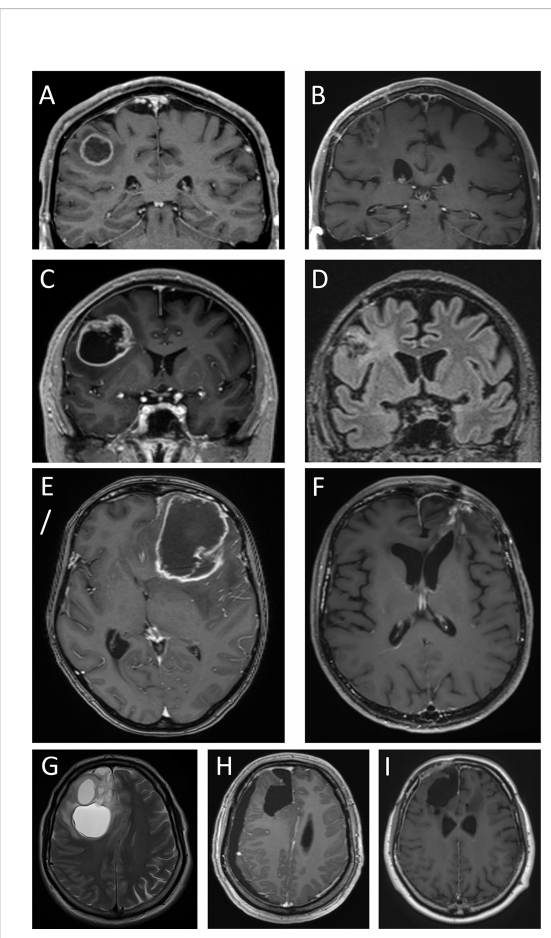
FIGURE 4 Four cystic glioblastomas before and after tumor surgery. T1 weighted MPRAGE MRIs after intravenous injection of gadolinium-based contrast medium (which gives the ring- formed bright signal in most images), except in D and G, which are T2-weighted and T2-weighted FLAIR, respectively. Images (A, C, E, G) show pre-surgical MRIs. Note the modest displacement of surrounding brain tissue (compare with contralateral side). Images (B, D, F, H, I) show MRIs after 240, 295, 330, 39 days, and 45 months, respectively. Tumors in images (A , C) were assessed as having minimal mass effect, tumors in images (E , G) had pronounced mass effect. Note the absence of brain tissue where the tumor and cyst resided; this comprises white matter and adjacent neocortex.